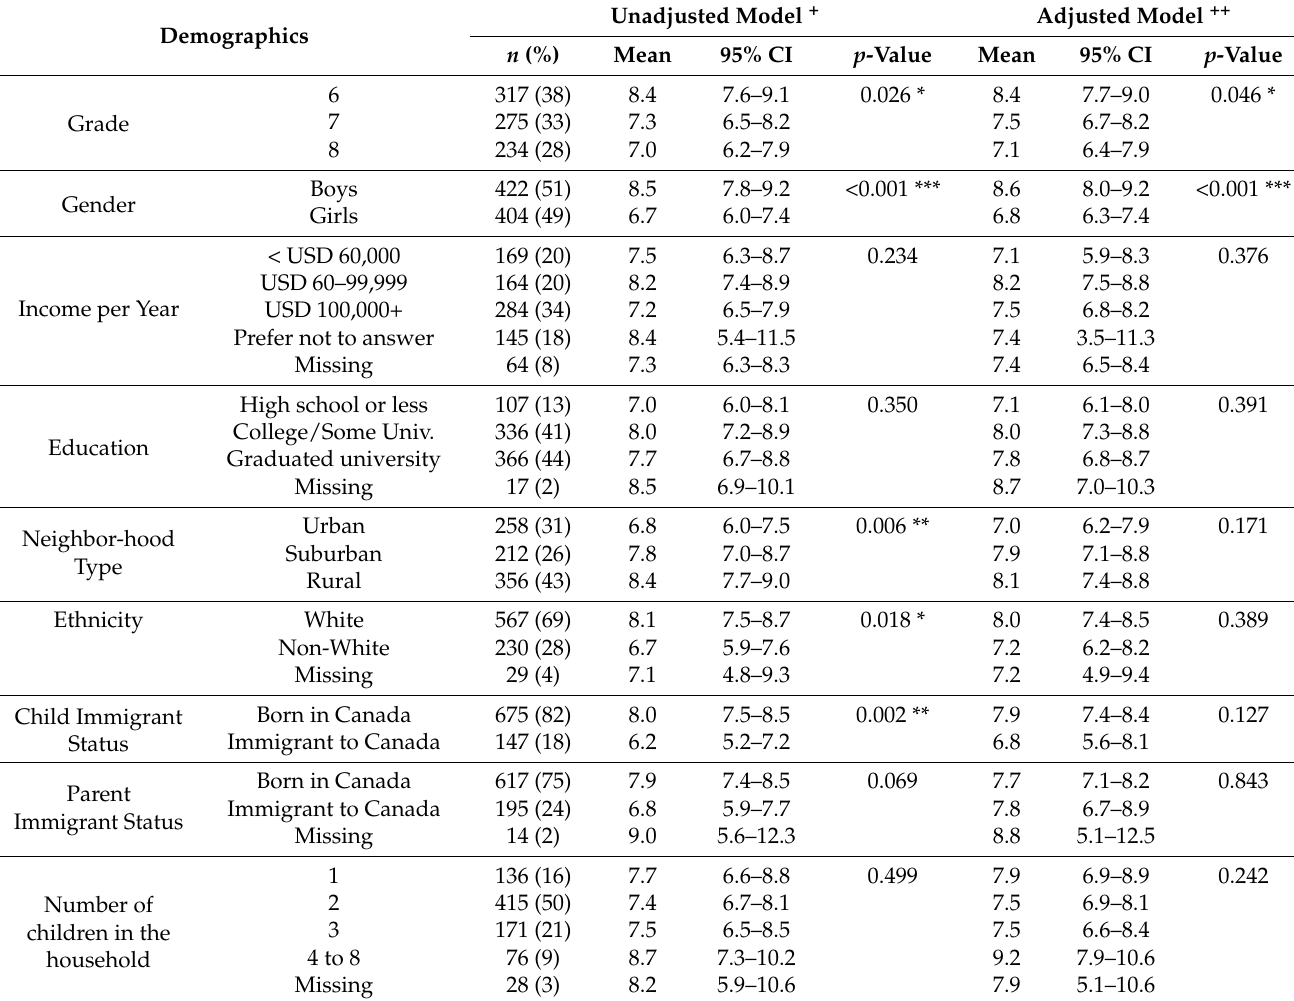
Table 3. Demographic Characteristics: Descriptives and Model 1 Results 1